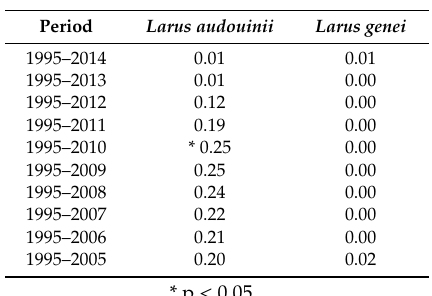
Table 6. Coefficients of determination (R 2 ) of the general linear models (GLMs), using two endangered bird species ( Larus audouinii and Larus genei ) as the dependent variable and mean annual discharge as the independent variable, within an iteration process with different years.